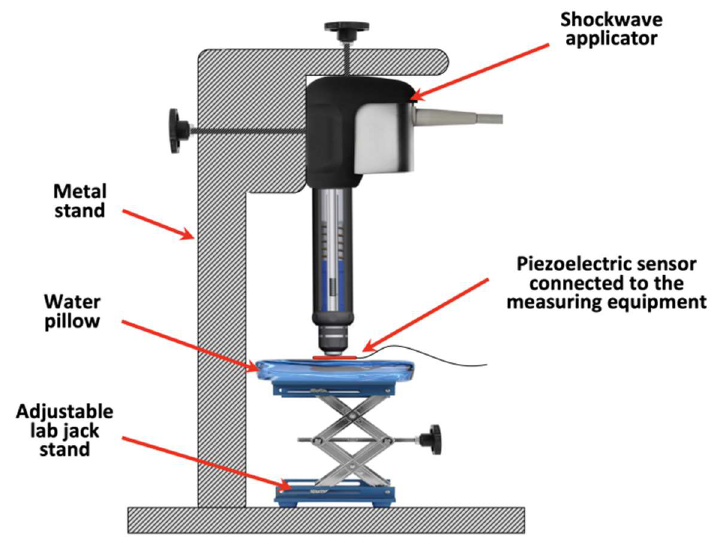
Figure 6. Test bench with piezoelectric sensor—vibrometer.